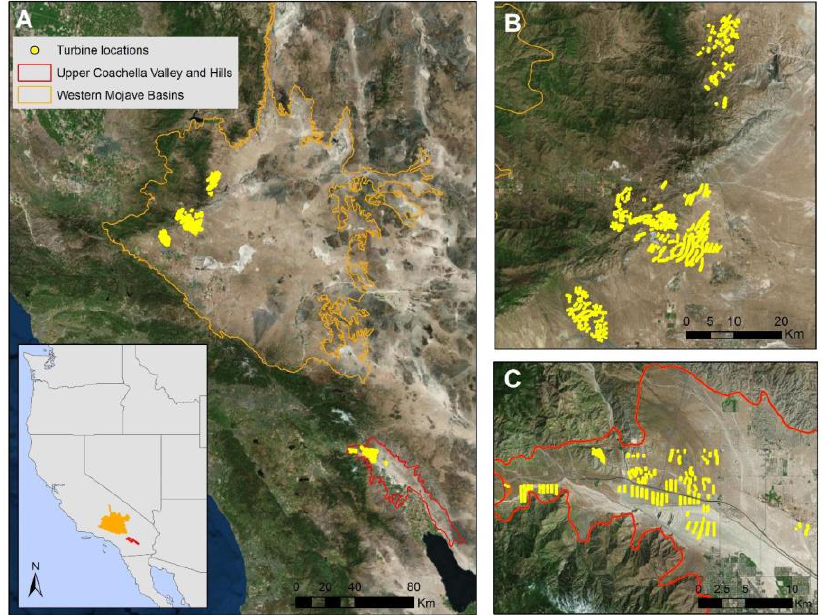
Figure 1. ( A ) Locations of the study turbines in relation to the Western Mojave Basins and the Upper Coachella Valley and Hills Level IV Ecoregions in California. Zooms of ( B ) the Tehachapi area in the Western Mojave Basins, and ( C ) the Desert Hot Springs area in the Upper Coachella Valley and Hills